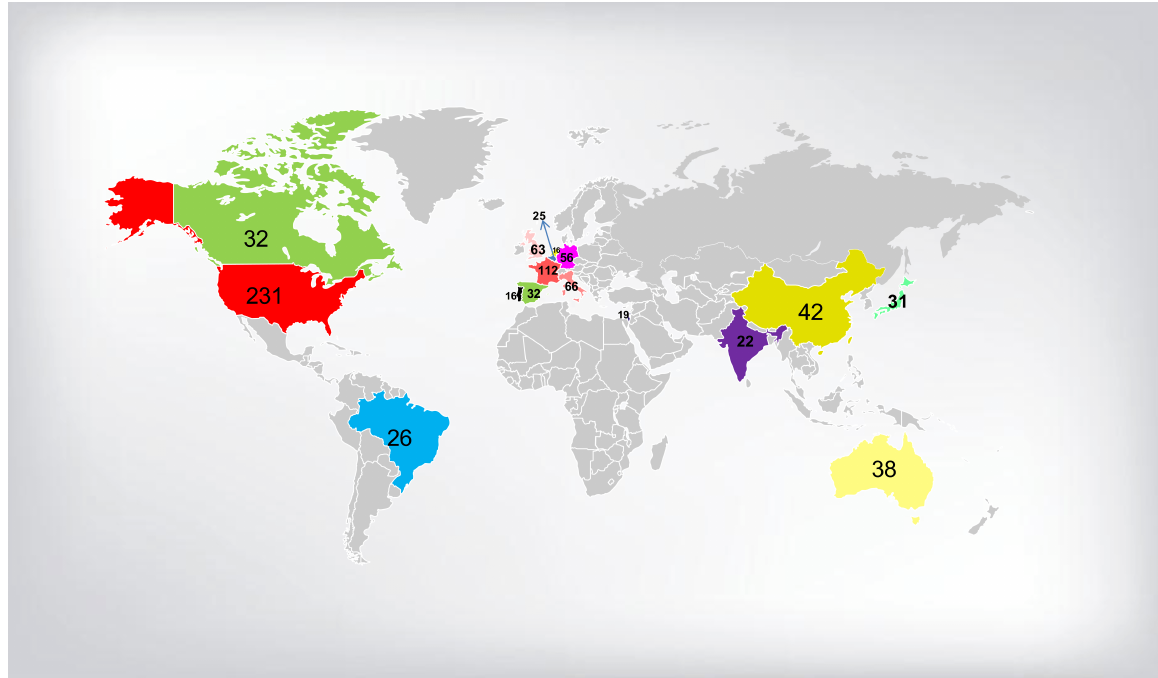
Fig. 4. The global distribution of the top 15 productive countries in AVD research. Table 2. The top 15 productive and cited country on the research of absence of vas deferens. Ranking Country Frequency Cited (times) 1st USA 231 10560 2nd France 112 4094 3rd Italy 66 3061 4th England 63 1951 5th